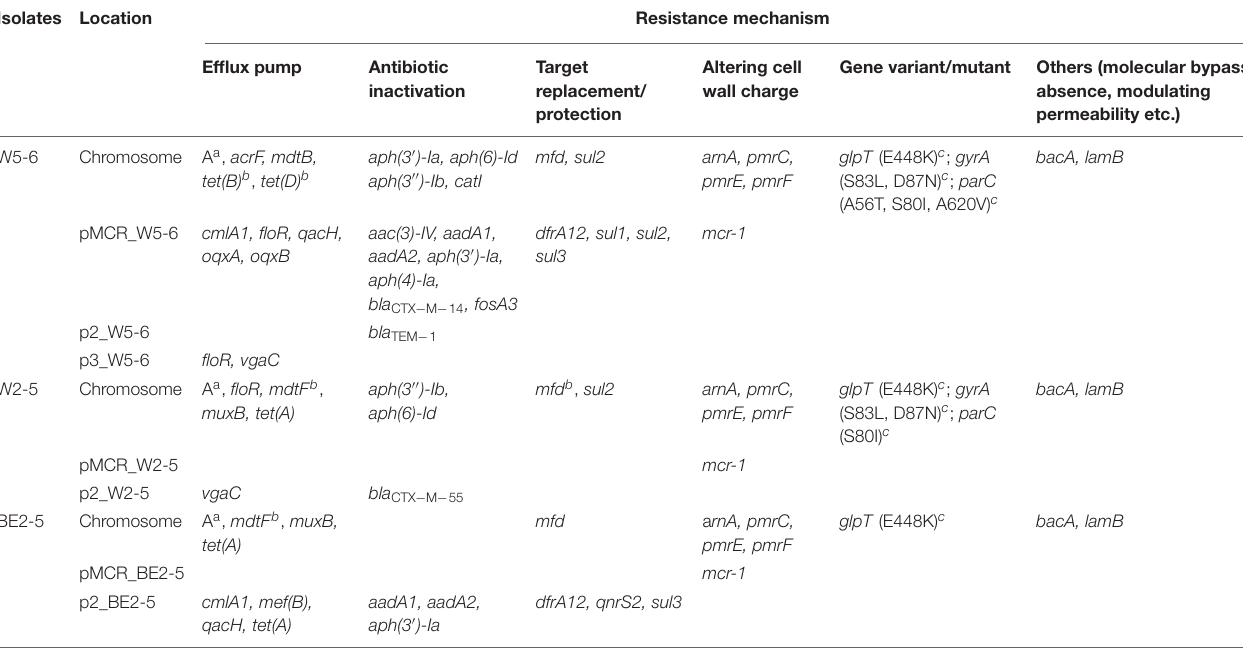
TABLE 3 | CARD database annotated ARGs in three E. coli isolates. Isolates